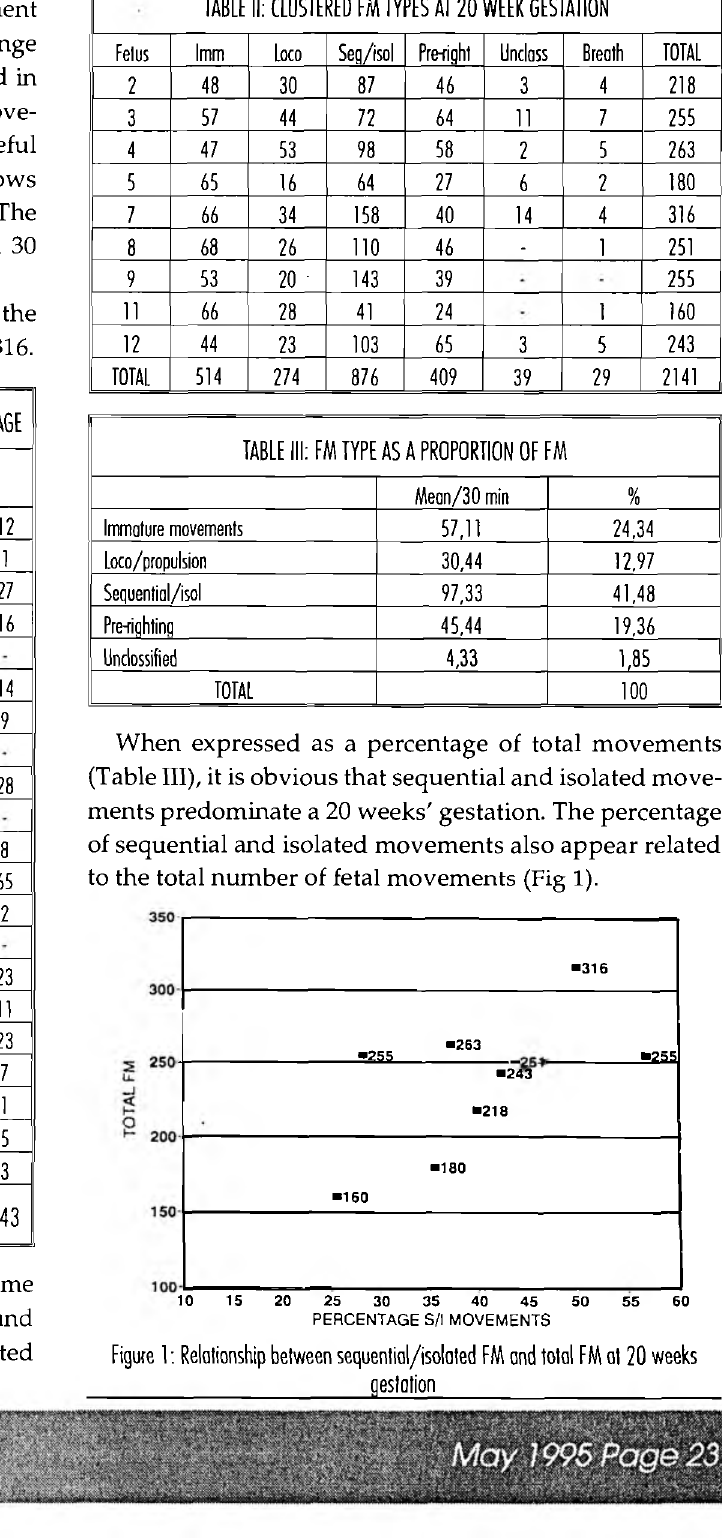
TABLE II: CLUSTERED FM TYPES AT 20 WEEK GESTATION